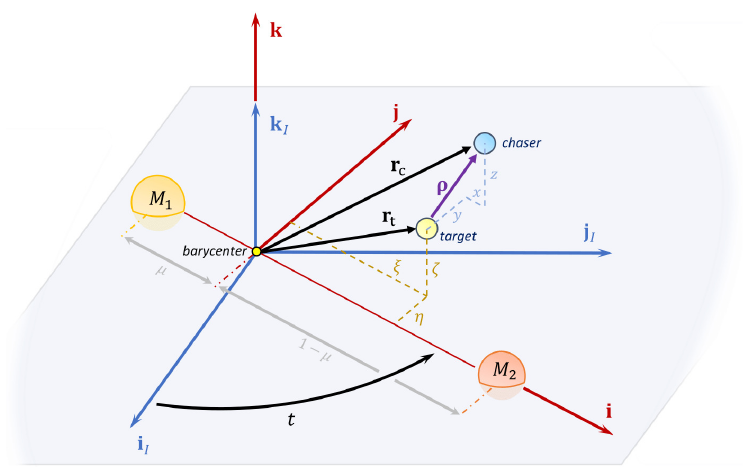
Figure 1. Relative orbital motion in the